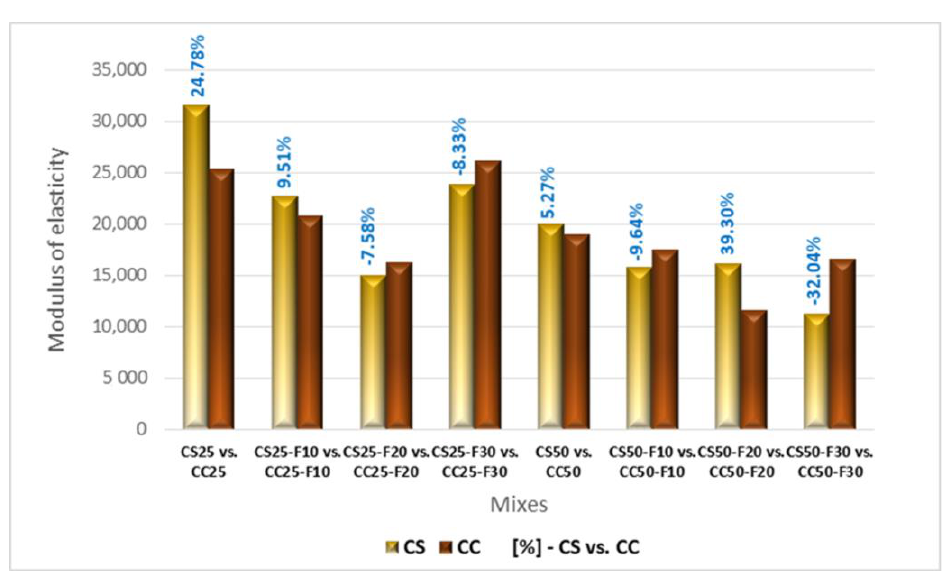
Figure 22. Variation of modulus of elasticity for composites with sunflower aggregates versus composites with corn cobs aggregates [%].